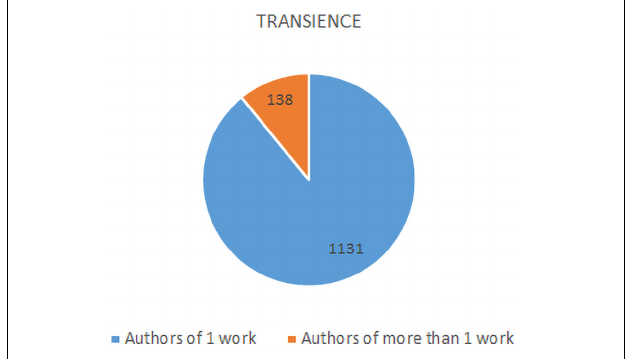
FIGURE 4 | Transience of authors in art therapy publications.